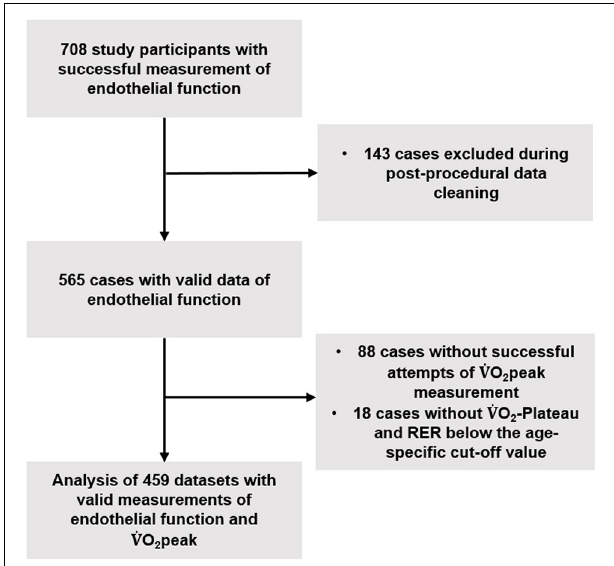
FIGURE 1 | Flow-chart of data acquisition and cleaning. ˙VO 2 peak = peak oxygen consumption, RER = respiratory exchange